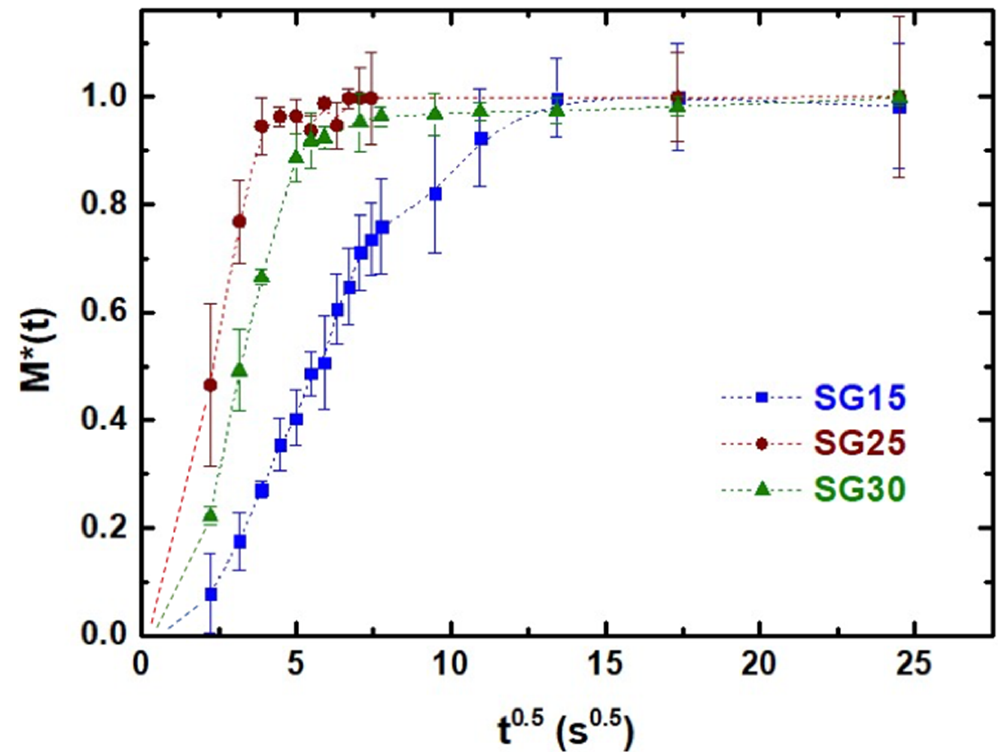
Figure 6. Normalized weight gain (M*(t) = M(t)/M ∞ ) for PBS uptake in SG15, SG25 and SG30 versus the square root of time. Linear fittings were performed for up to 80% of the processes for SG15, SG25, and SG30. Correlation values of R 2 > 0.984 in all cases. The dashed lines represent the eye guide.